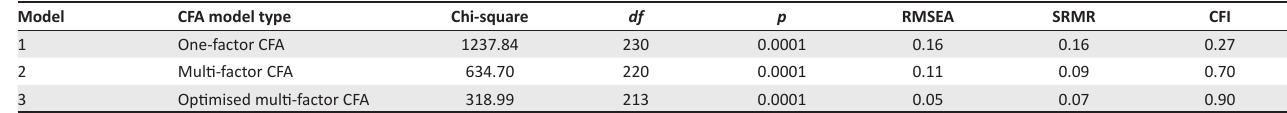
TABLE 2: Construct validity of overall measurement model. Model